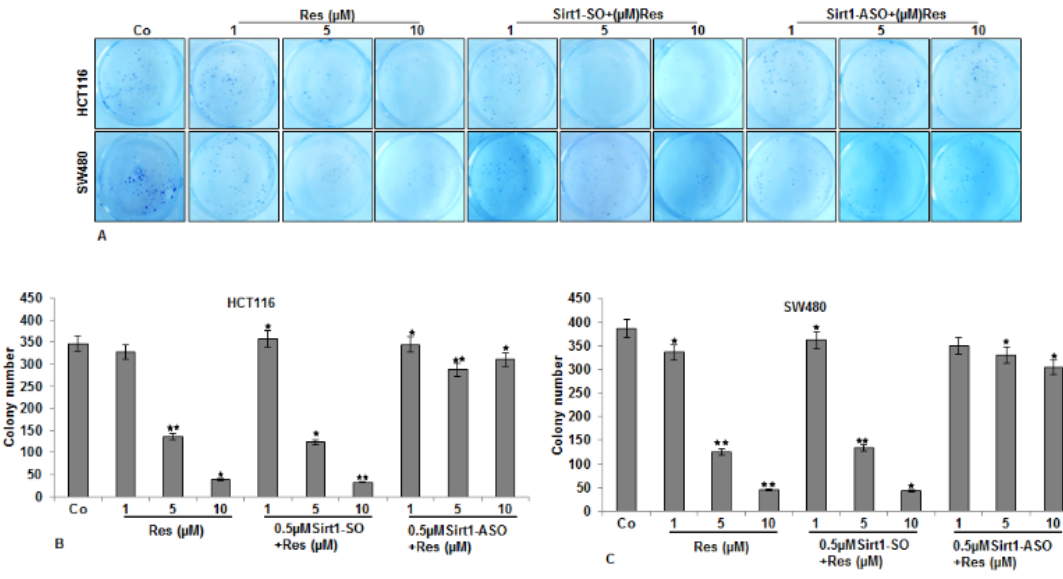
Figure 3. Effects of resveratrol and Sirt1-ASO on the invasion of CRC cells in alginate culture. ( A ) Serum-starved HCT116 and SW480 cell lines in alginate culture (1 × 10 6 /mL) were either left untreated or treated as described above (Figure 2) and emigrated spheroids evaluated by toluidine blue staining after 14 days; ( B , C ) The spheroid numbers of emigrated HCT116 ( B ) and SW480 ( C ) cells through alginate beads was quantified after 14 days in culture. The values given are the means ± standard errors of the mean of three replicates. One of three independent experiments is shown. Values were compared to the control, and statistically-significant values with p < 0.05 are designated by an asterisk (*); p < 0.01 by two asterisks (**).